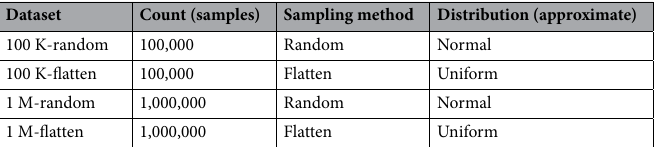
Table 1. The four sampling approaches used to subset the approx. 6M docking scores for OZD.